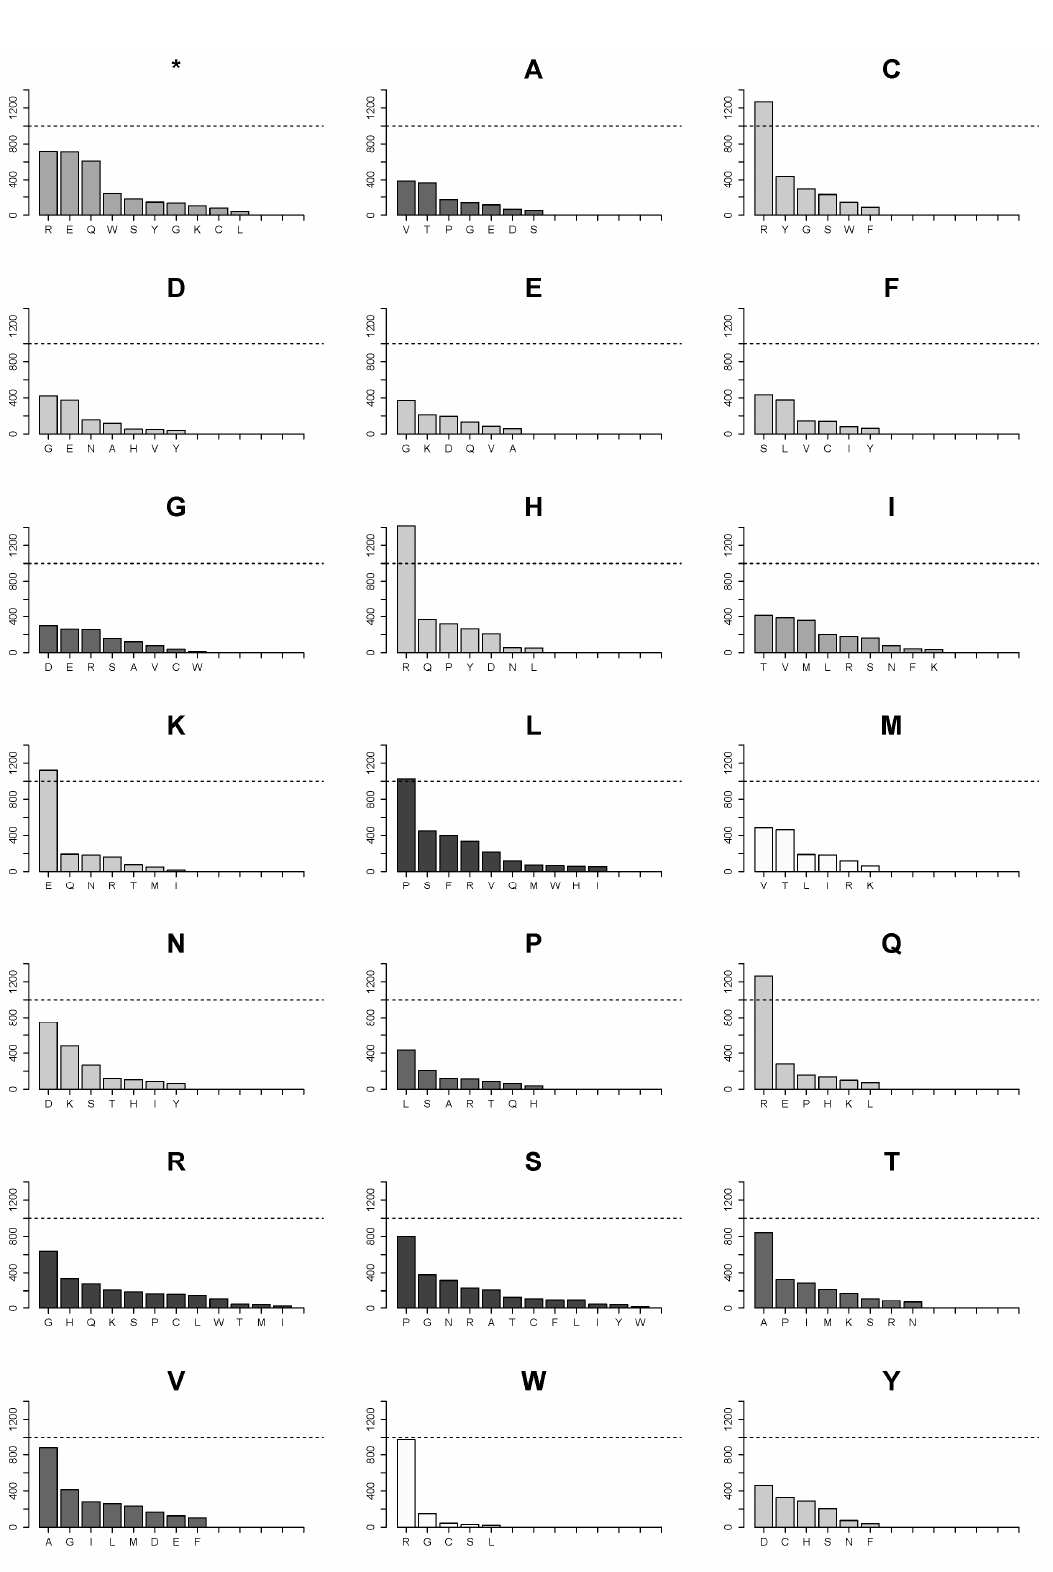
Figure 5. Landscape of ways of gain of each amino acid in individual substitutions that result in introductions of each of 20 amino acids and a truncation of proteins in mutations in the CCLE database. The dotted horizontal line marks 1000 substitution events. The bars in each graph are colored according to the number of codons for a respective amino acid similarly to the previous graphs. The letter in the title of each graph denotes an amino acid that is gained in mutations.